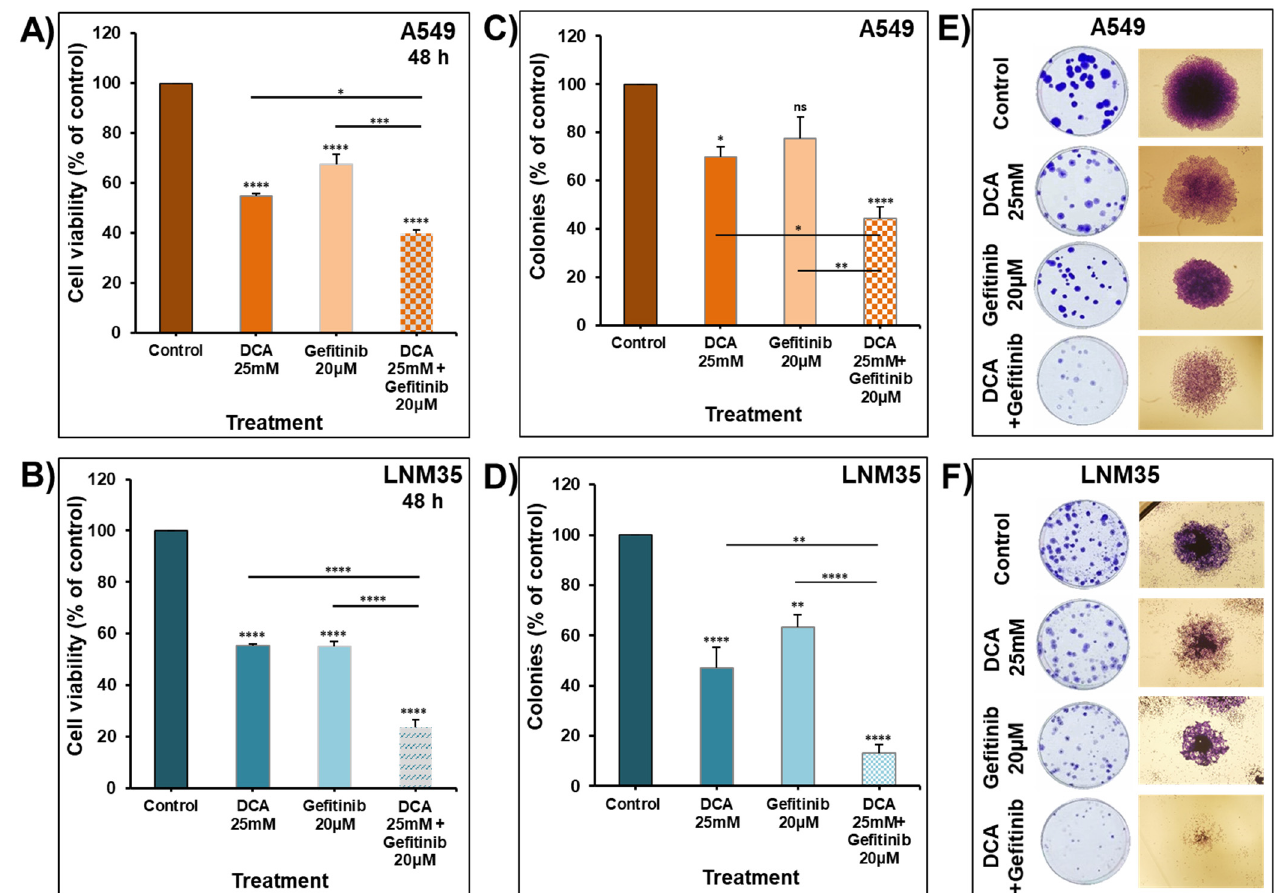
Figure 10. Effect of DCA in combination with gefitinib on NSCLC cells’ viability and colony growth. Exponentially growing A549 ( A ) and LNM35 ( B ) cells were treated, respectively, with DCA (25 mM) ± gefitinib 20 µM. Cellular viability was determined using CellTiter-Glo luminescent assay. ( C , D ) Treatment of the pre-formed colonies of A549 and LNM35 cells, respectively, with DCA (25 mM) ± gefitinib 20 µM for 7 days, after which colonies were fixed, stained and counted as described in the Materials and Methods. ( E , F ) Representative images of the colonies for the control and treated groups are shown for A549 and LNM35 cancer cells. All experiments were repeated at least 3 times. Columns are means; bars are S.E.M. * Significantly different at <0.05. ** Significantly different at <0.01. *** Significantly different at <0.001. **** Significantly different at <0.0001. ns—non-significant.